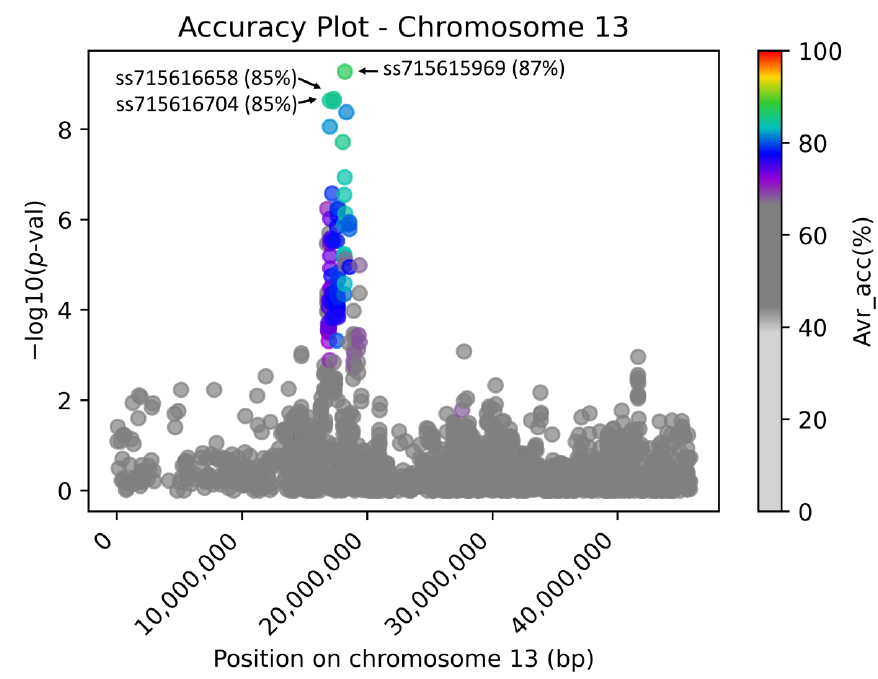
Figure 5. The AccuCalc chromosome-wise view of the associated region with flower color on chro- mosome 13 accentuated with calculated accuracy. The Manhattan plot for soybean data (SoySNP50K chip genomic data and purple/white flower color phenotype data) with average accuracy to the causative mutation-associated SNP on chromosome 13 at position 17,316,756. In this example, the markers with the highest accuracy (shown for the three top points in parentheses) are also the markers with the highest − log10 ( p